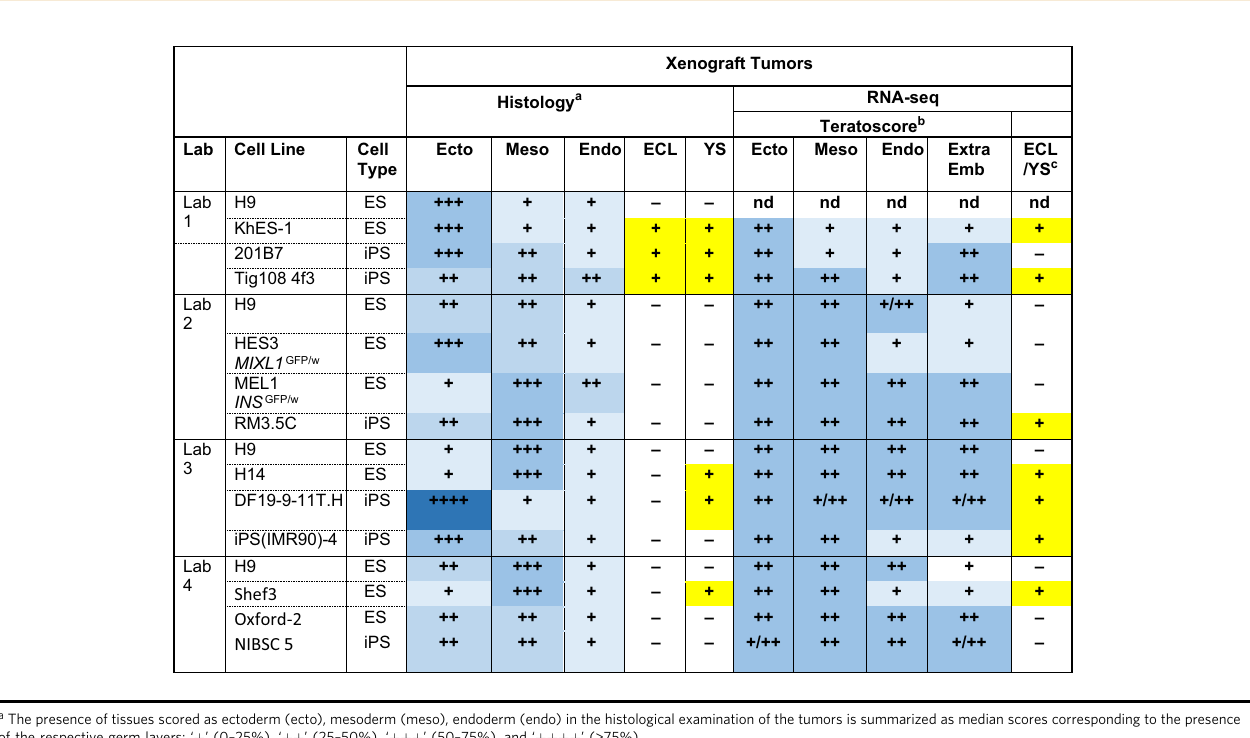
Table 1 Histology and teratoscore comparison of xenograft